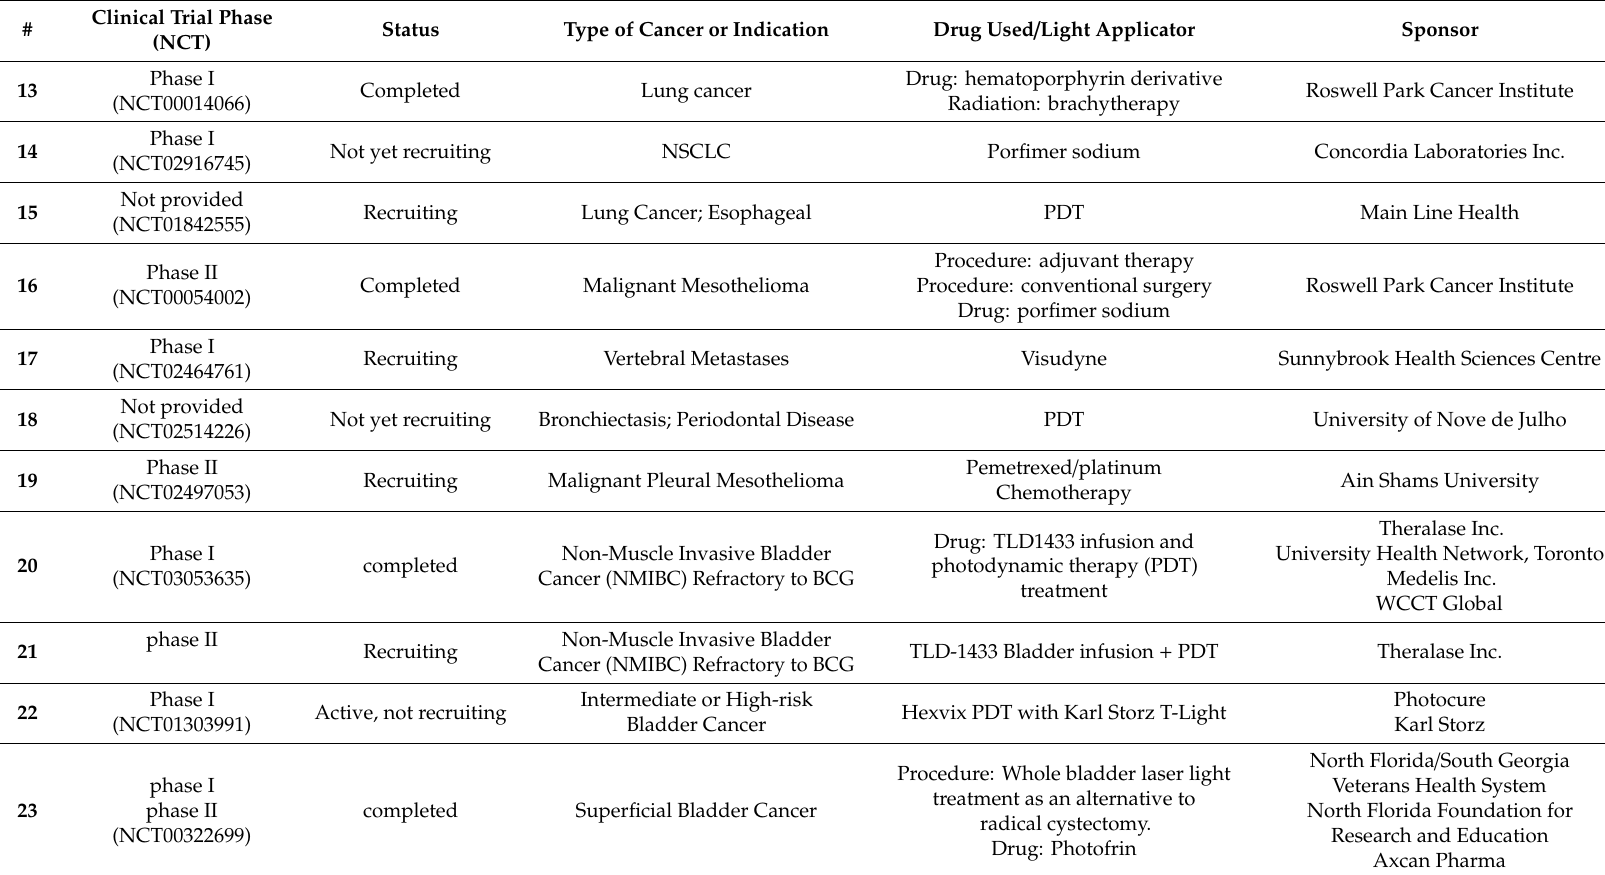
Procedure: Whole bladder laser light treatment as an alternative to radical cystectomy. Drug: